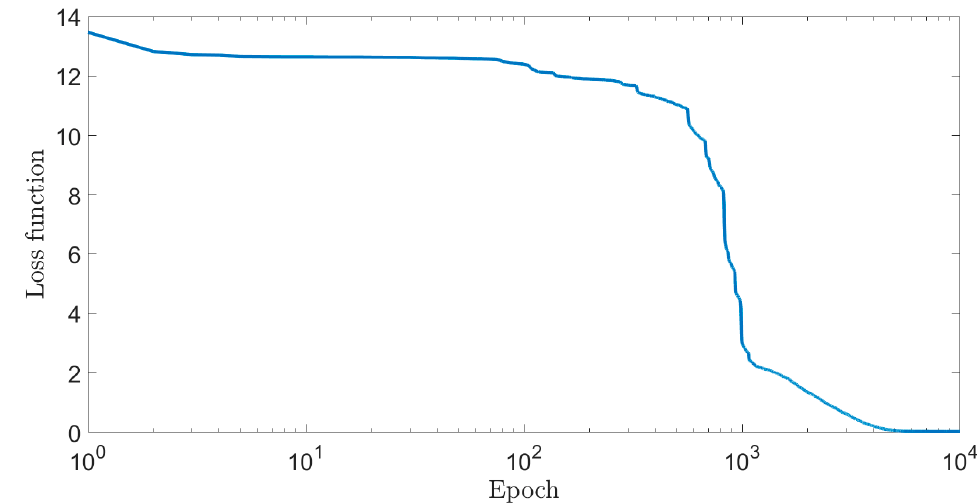
Figure 6. RMSE cross-validation. The optimal value of λ is set near to 10 − 3 .